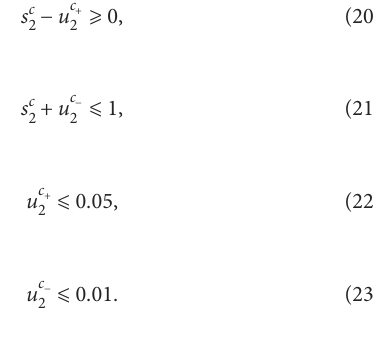
The retailer contracts of the members C and PVB specify that they are charged at 1€/kWh and 2€/kWh for electricity consumption, respectively. These retailer contracts also specify that the surplus of electricity production of these members injected into the network is not bought back. In other words, the selling prices are